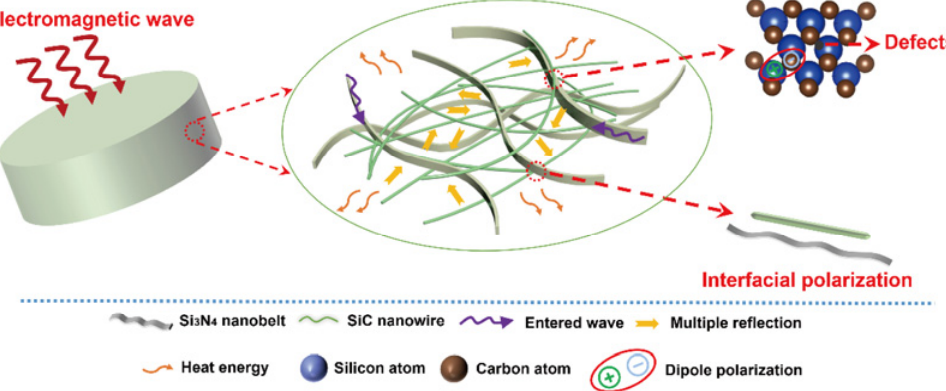
Fig. 7 Schematic illustration of the EM wave absorption mechanisms of SiC/Si 3 N 4 composite